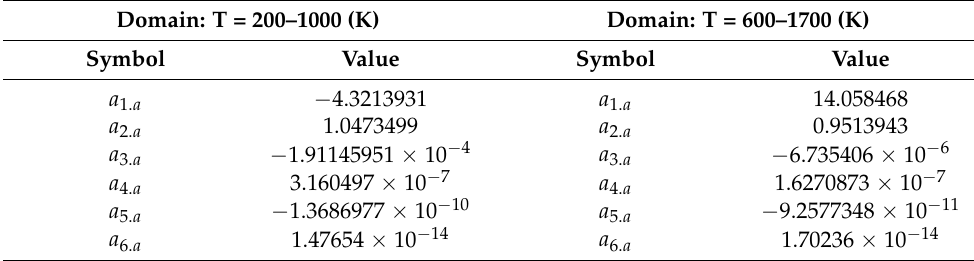
Table 1. Air enthalpy polynomial coefficients.